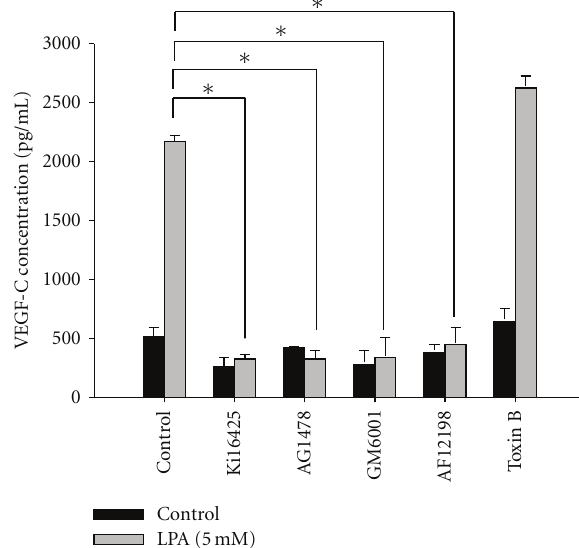
Figure 3: Lysophosphatidic acid- (LPA-) stimulated vascular endothelial growth factor- (VEGF-) C protein expression is mediated through endothelial growth factor receptor (EGFR) transactivation-, matrix metalloproteinase- (MMP-), LPA1/3-, and interleukin- (IL-) 1R-dependent mechanisms in human umbilical vein endothelial cells (HUVECs). Starved HUVECs were pretreated with AG1478 (100nM), AF12198 (10nM), GM6001 (10 μ M), Ki16425 (10 μ M), and toxin B (10nM) for 1h, followed by LPA (5 μ M) treatment for an additional 24h. Conditioned medium was measured by an ELISA as described in “Methods”. All ELISA data are expressed as the mean ± SD from at least three independent experiments. ∗ P < . 05, ∗∗ P < . 01, and ∗∗∗ P < . 001 indicate a statistically significant di ff erence with the untreated